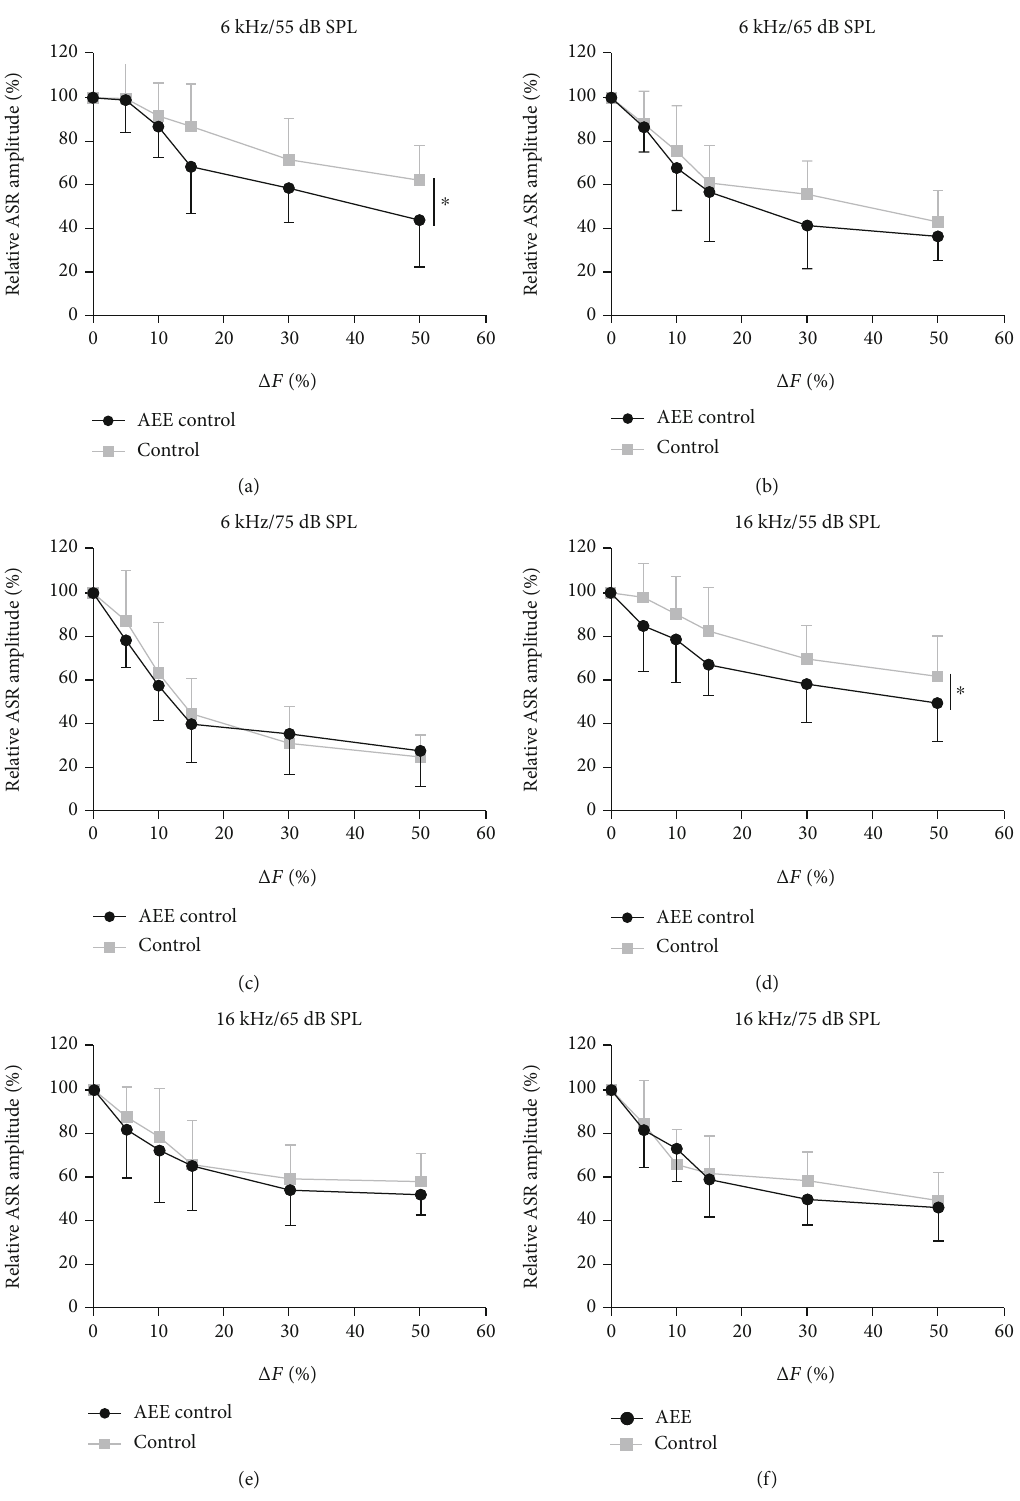
Figure 5: Group-averaged functions showing PPI as a function of Δ F of the background pure tone at frequencies of 6 kHz (a – c) and 16kHz (d – f) ( mean ± SD ). (a) and (d) illustrate the results at the 55dB SPL sound intensity, (b) and (e) show data obtained at the 65dB SPL sound intensity, and (c) and (f) show data obtained at the 75 dB SPL sound intensity. Statistical signi fi cance: (a) ∗ p < 0 : 05 ; (b) p = 0 : 13 ; (c) p = 0 : 64 ; (d) ∗ p < 0 : 05 ; (e) p = 0 : 39 ; (f) p = 0 : 63 , RM two-way